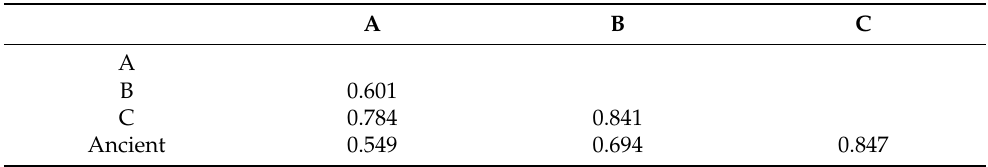
Table 1. Genetic distance between different groups of the WRKY66s calculated based on the amino acid sequences with the Jones–Taylor–Thornton (JTT) model. A B C